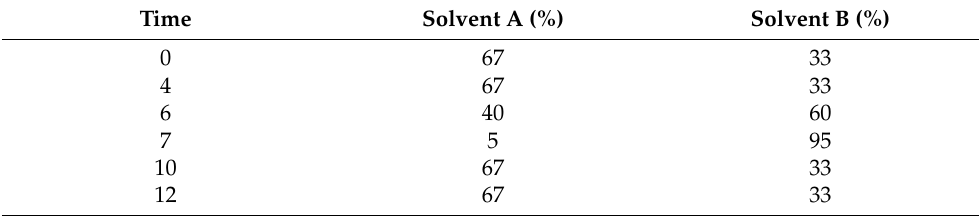
Table 1. Mobile phase gradient of the method: A = Water 10 mM Ammonia Acetate; B = Methanol. Time Solvent A (%) Solvent B (%) 0